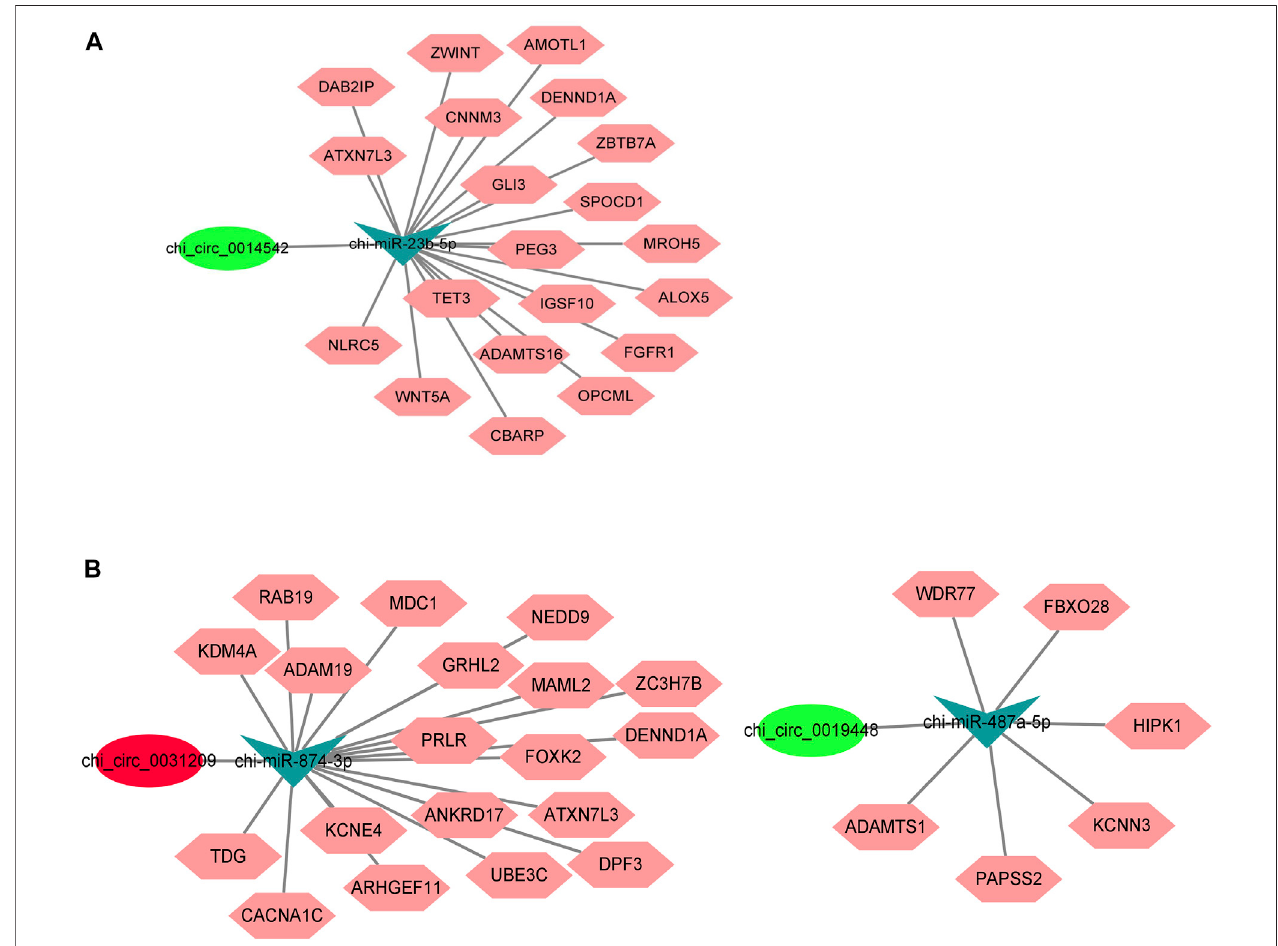
FIGURE 8 | Predicted competing endogenous RNA (ceRNA) network involving (A) chi_circ_0014542, (B) chi_circ_0031209 and chi_circ_0019446.